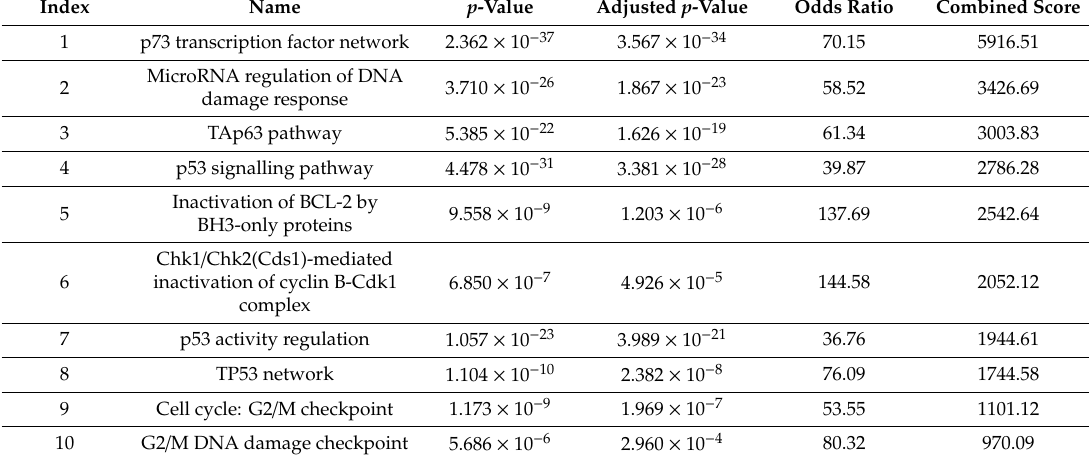
Table 2. Signaling pathways deduced from TAp73 target genes identified from the focused studies. Top signaling pathways analyzed using the 81 TAp73-regulated target genes from the 71 individual focused studies were derived by analysis with Enrichr (https: // amp.pharm.mssm.edu / Enrichr /